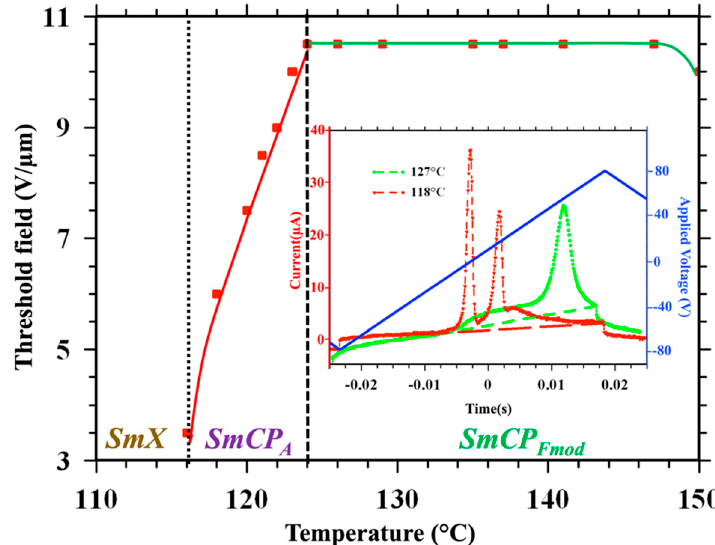
Figure 3. Main pane: Temperature dependence of switching electric threshold (where polarization peak appears). Inset shows the time dependences of electric current at 127 °C in the B 7 phase (green) and at 118 °C in the B2 phase under Vpp = 160 V, f = 23 Hz triangular wave voltage (red). The error of the threshold field is ± 0.2 V/µm.